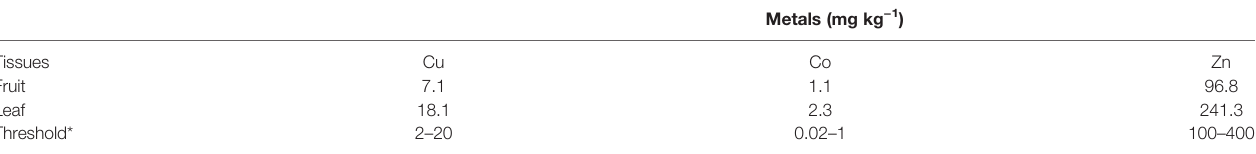
TABLE 5 | Trace metal concentration in fruits and leaves of P. guajava from the tailing tree plantation.